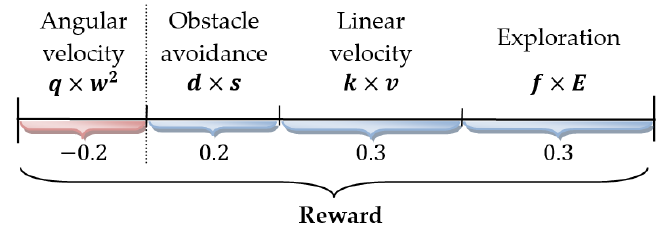
Figure 8. The reward function normalization.